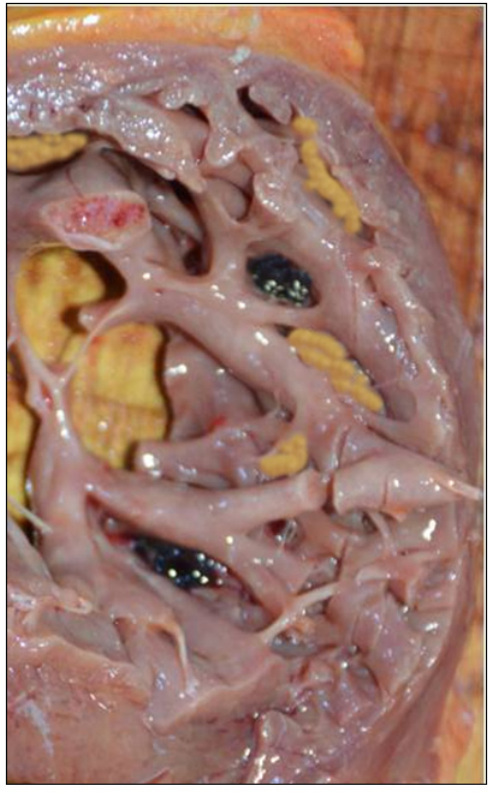
Figure 3. Necropsy aspect of the left ventricular wall revealed at